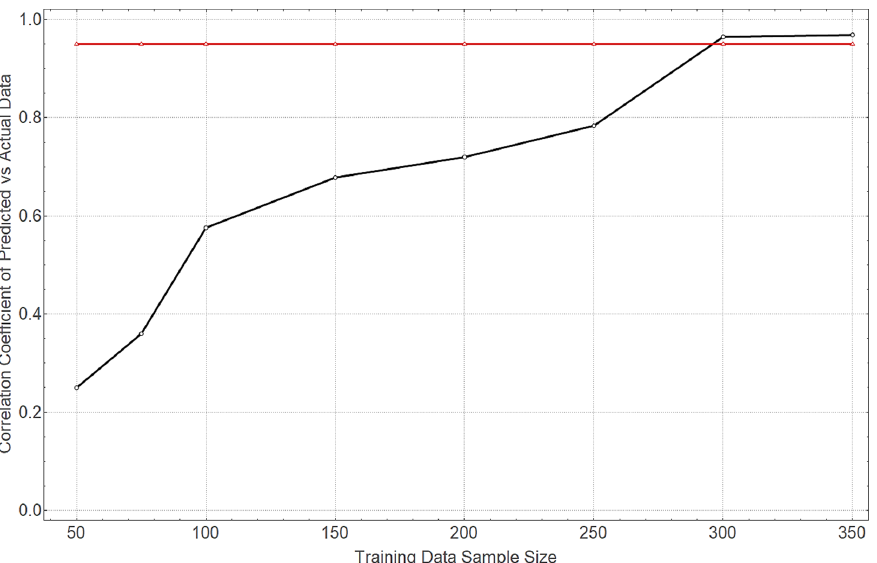
Figure 3. Sensitivity of forecasts (55 timesteps) based on wavelet packet transforms to sample size (number of training points). The dashed line shows the 95% accuracy level. Source: authors’ cal- culations.